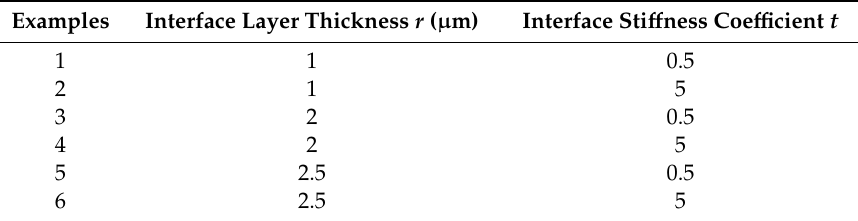
Table 9. Interface layer simulation example